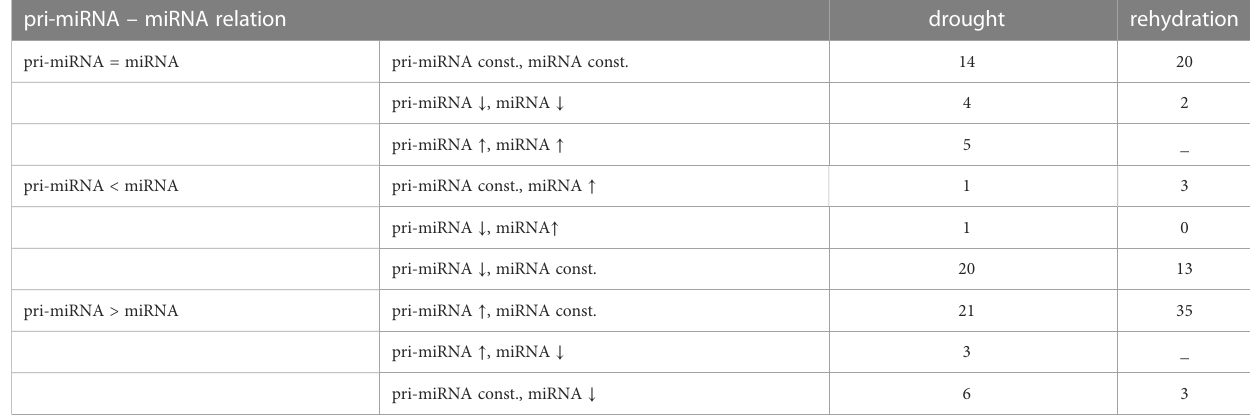
TABLE 3 Accumulation changes of miRNAs in relation to the cognate pri-miRNAs during drought or